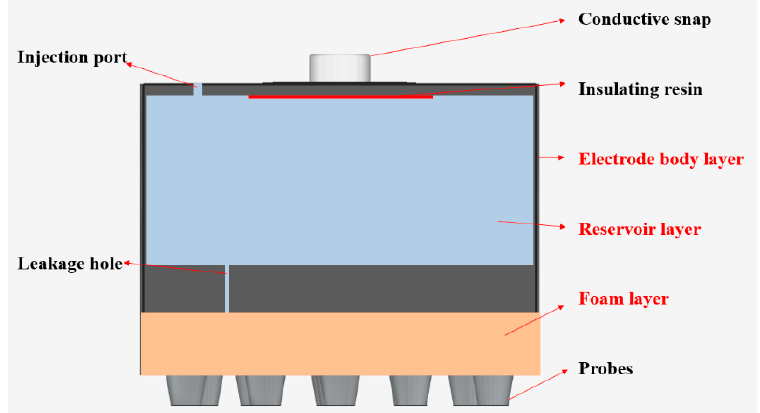
Figure 1. Structural diagram of the flexible multi-layer semi-dry electrode.